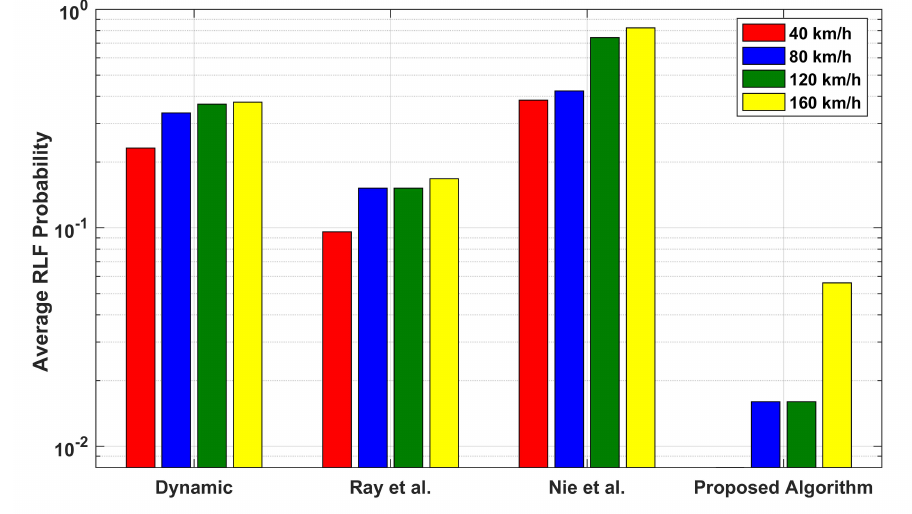
Figure 8. Average probability of RLF for different